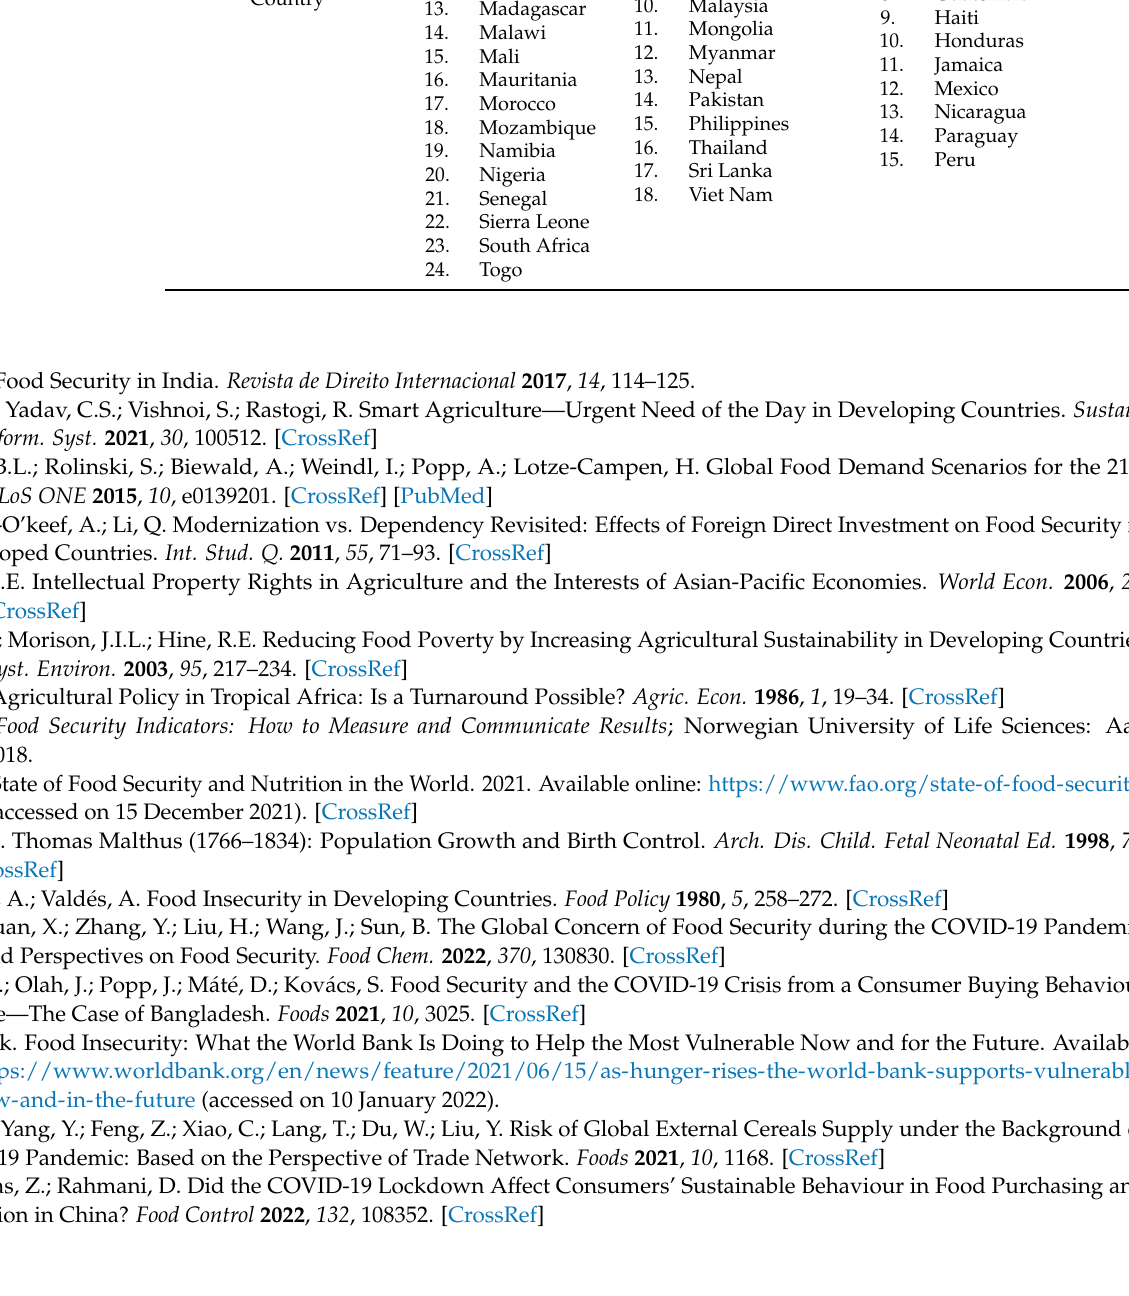
Table A1. List of countries in this study. Continent Africa Asia LAC Country